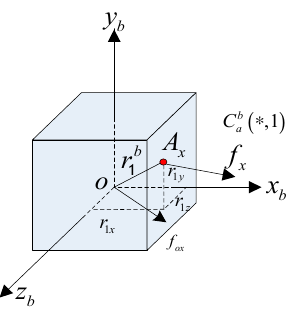
r Figure 2. Diagram of dynamic error caused by the size effect. In Figure 3, accelerometer